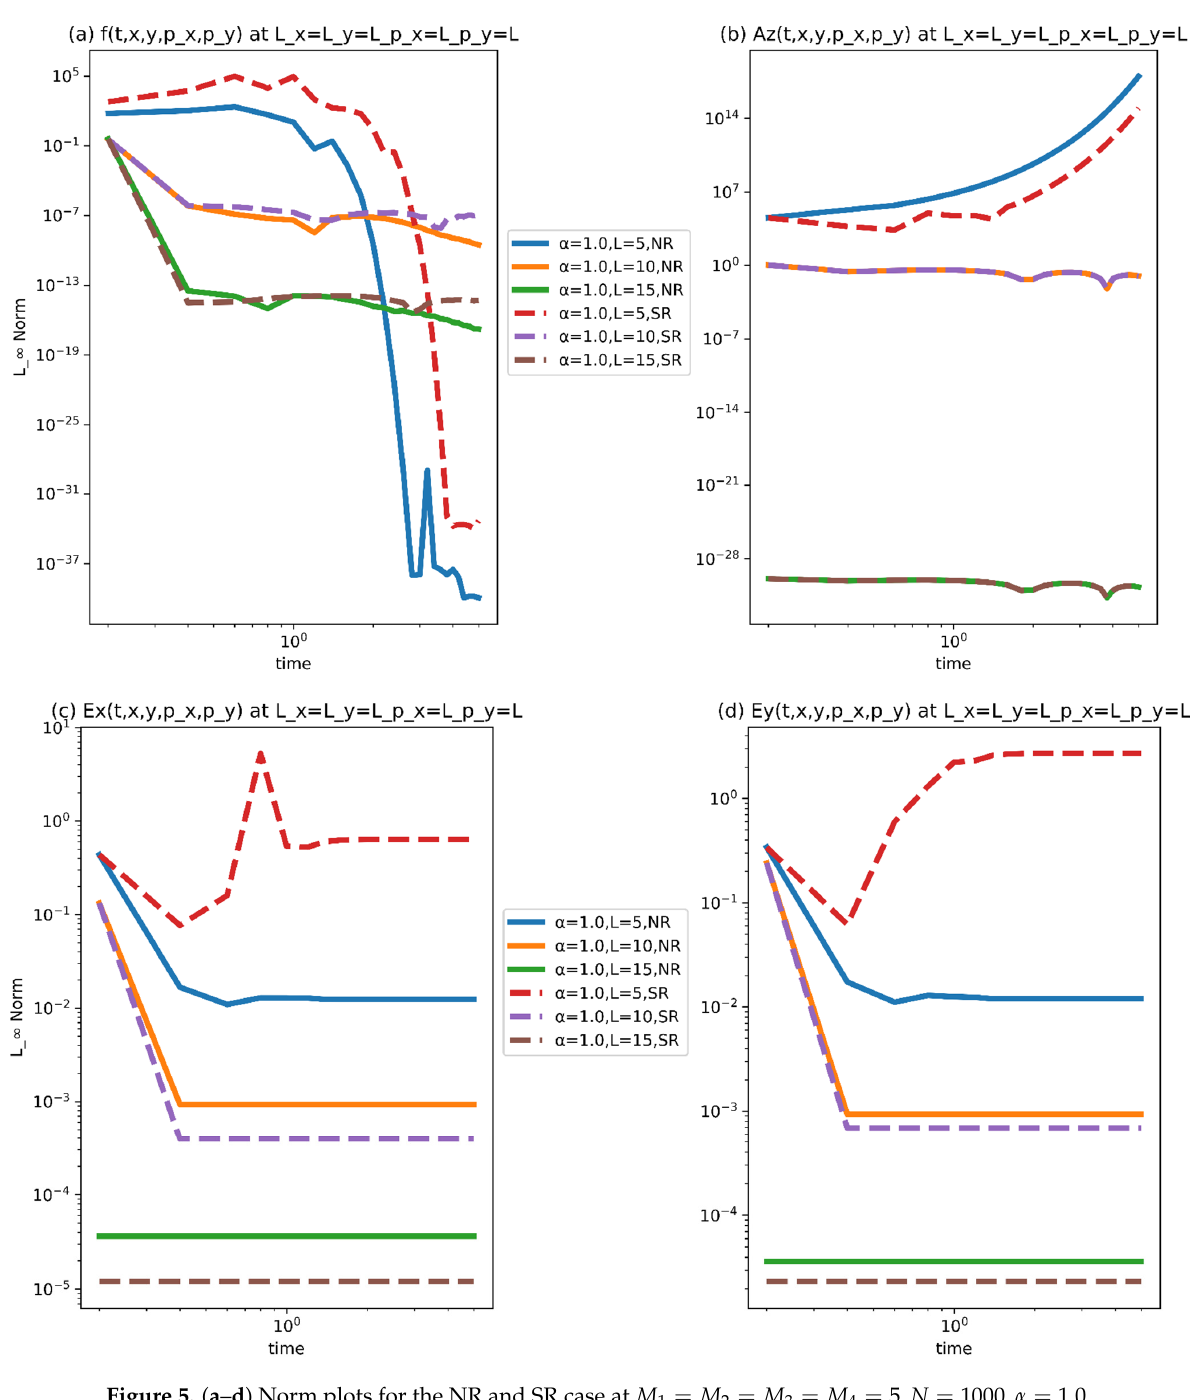
α= = = = = = Figure 5. ( a – d ) Norm plots for the NR and SR case at N . Figure 5. ( a – d ) Norm plots for the NR and SR case at M 1 = M 2 = M 3 = M 4 = 5, N = 1000, α = The coated layer expands itself due to the transformation of plasma particles, which α= = (see Figure 7i(b)). The dark portion of the domain shows can be seen at 9.0, 0.6 t that there are no excited plasma particles is found in this area, and it is reducing gradually because plasma particles inside the coated layer are trying to adjust itself. To acquire the equilibrium condition, movement of immense volume of plasma particles can be per- α ceived from the upper part to the lower part with integer (see Figure 7i(c)). Further in Figure 7ii, we can see the variations produced due to the partial slip boundary conditions.